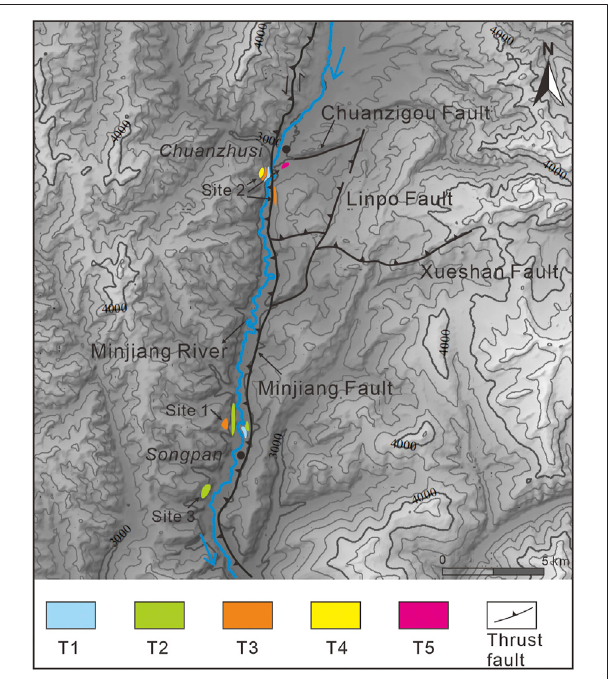
FIGURE 2 | DEM image showing the sites (marked as sites 1 – 3) investigated in the Songpan area, and the distribution of the seven fl uvial terraces and the faults (Kirby et al.,